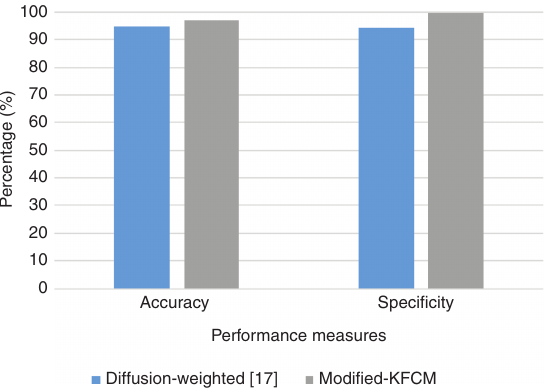
Figure 11: Graphical comparison of the proposed and existing method by means of accuracy and specificity.